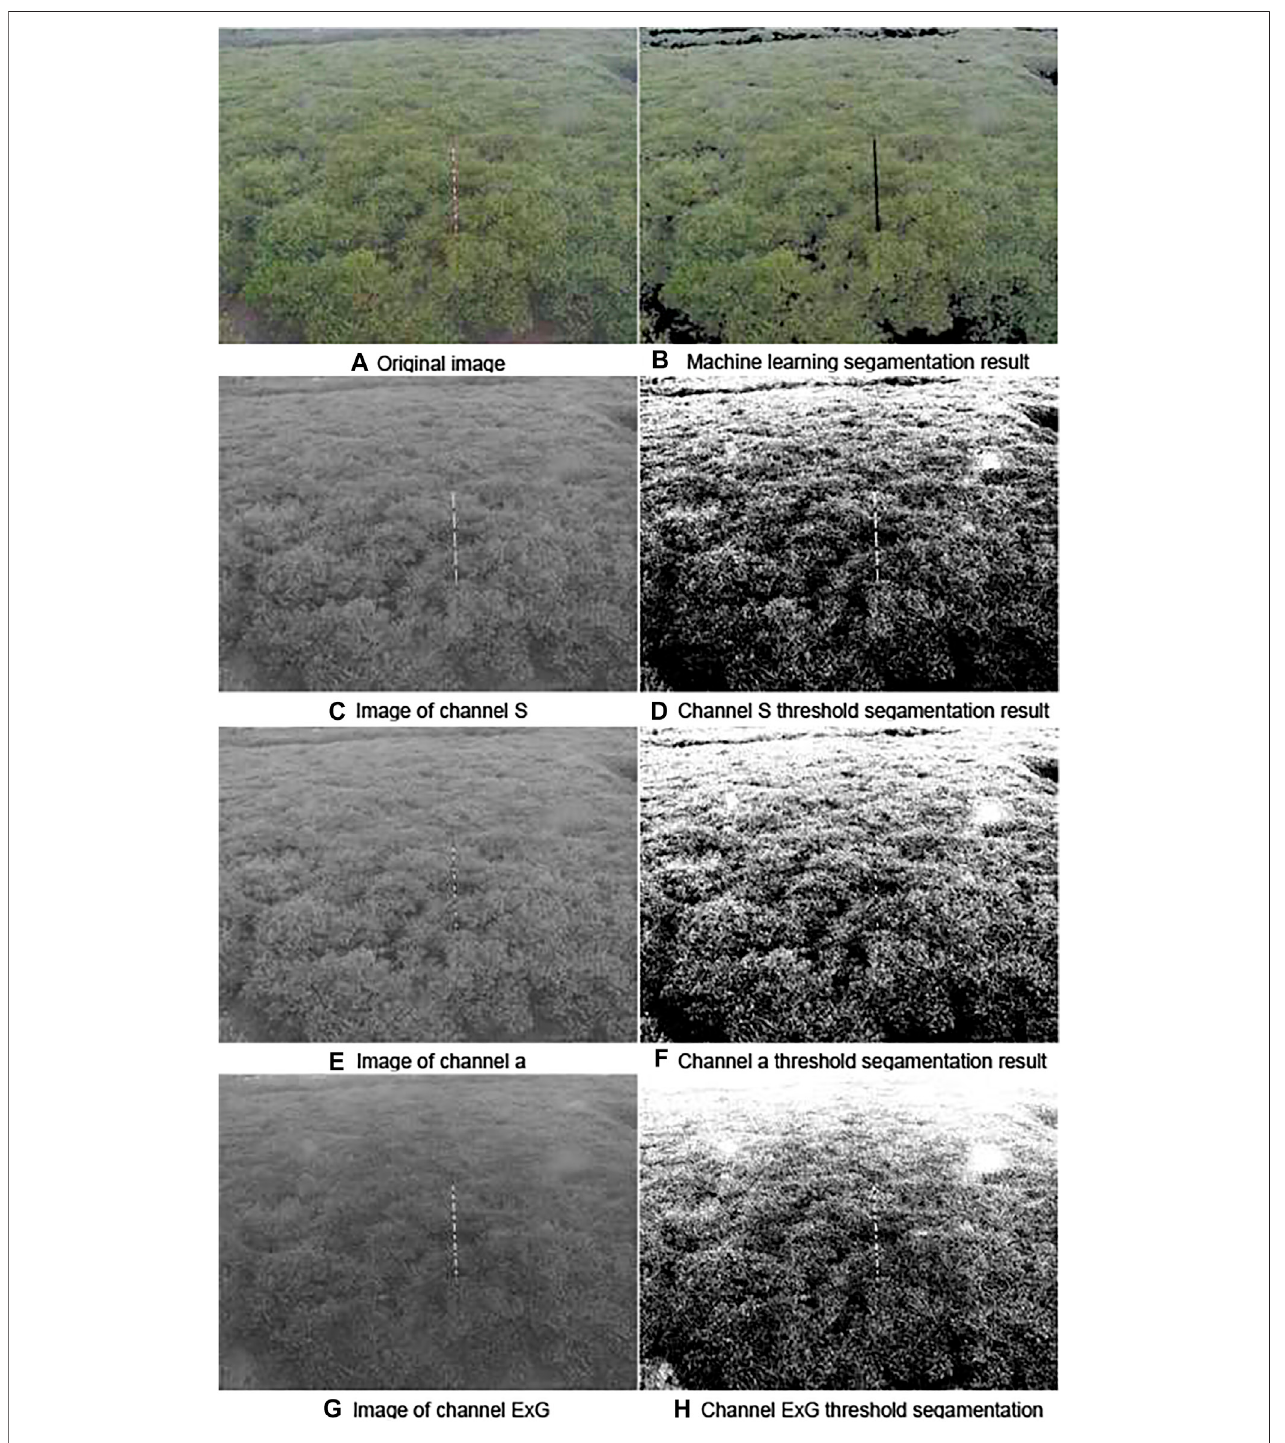
FIGURE 3 | Segmentation effects of mangrove vegetation images. (A) Original image. (B) Machine learning segmentation result. (C) Image of channel S. (D) Channel S threshold segmentation result. (E) Image of channel a. (F) Channel a threshold segmentation result. (G) Image of channel ExG. (H) Channel ExG threshold segmentation.